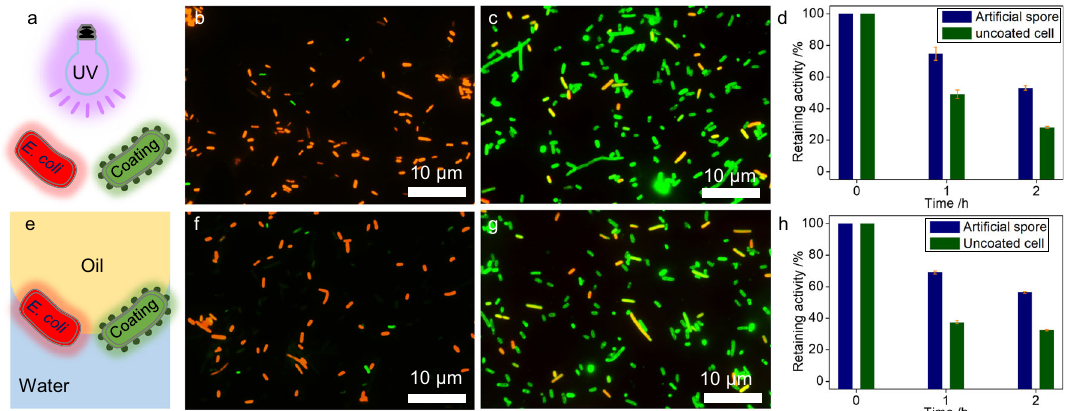
Fig. 4 The protectability of arti fi cial spores from external stresses. a Scheme of uncoated E. coli cell and arti fi cial spore under ultraviolet (UV) light irradiation. Live/dead assay of ( b ) uncoated cells and ( c ) arti fi cial spores after 2 h UV treatment; green - live cells; red - dead cells. d Benzaldehyde lyase (BAL) stability under UV treatment; blue columns - arti fi cial spores; green columns - uncoated cells. e Scheme of uncoated cell and arti fi cial spore under interfacial stress (i.e., toluene-water biphasic condition). Live/dead assay of ( f ) uncoated cells and ( g ) arti fi cial spores treated by 2 h interfacial stress; green - live cells; red - dead cells. h BAL stability under interfacial stress; blue columns - arti fi cial spores; green columns - uncoated cells. The results in ( d , h ) are the average values of three parallel experiments. The error bars represent the standard deviations of three parallel measurements, n =